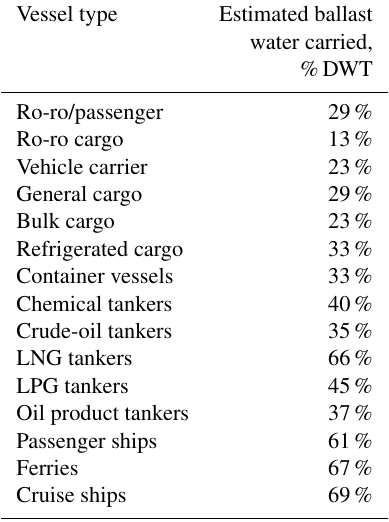
Table 2. Estimated volume of ballast water carried by different types of vessels, indicated with a fraction of vessel deadweight